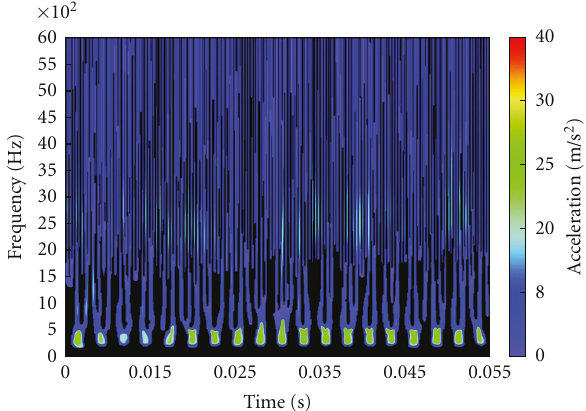
Figure 3: Frequency scalogram of wavelet coe ffi cient of the reference gear unit.